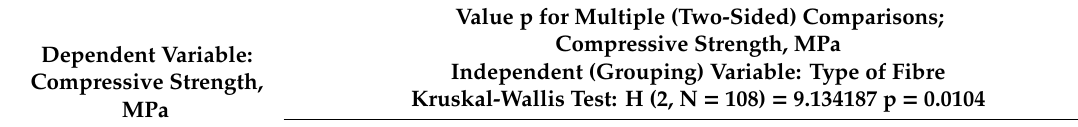
Table 11. Values p for two-sided comparisons.